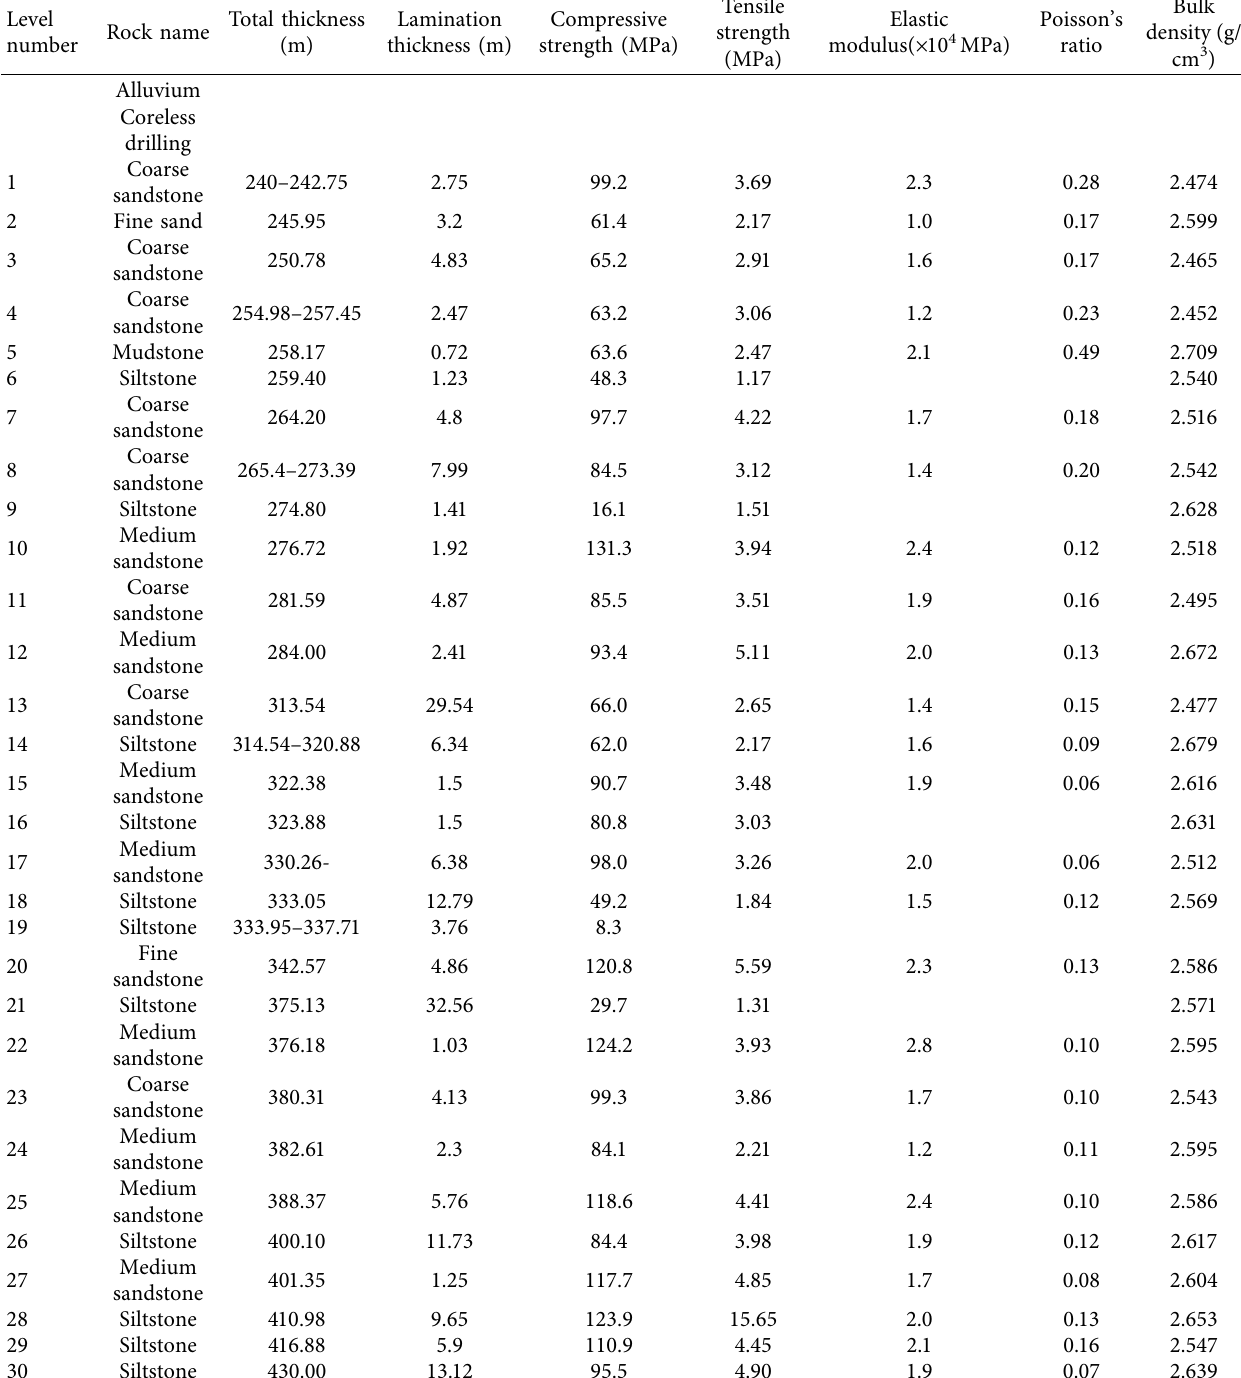
Table 1: Table of physical and mechanical test results of rock injected with three holes in the T2191 working face of Tangshan Mine.